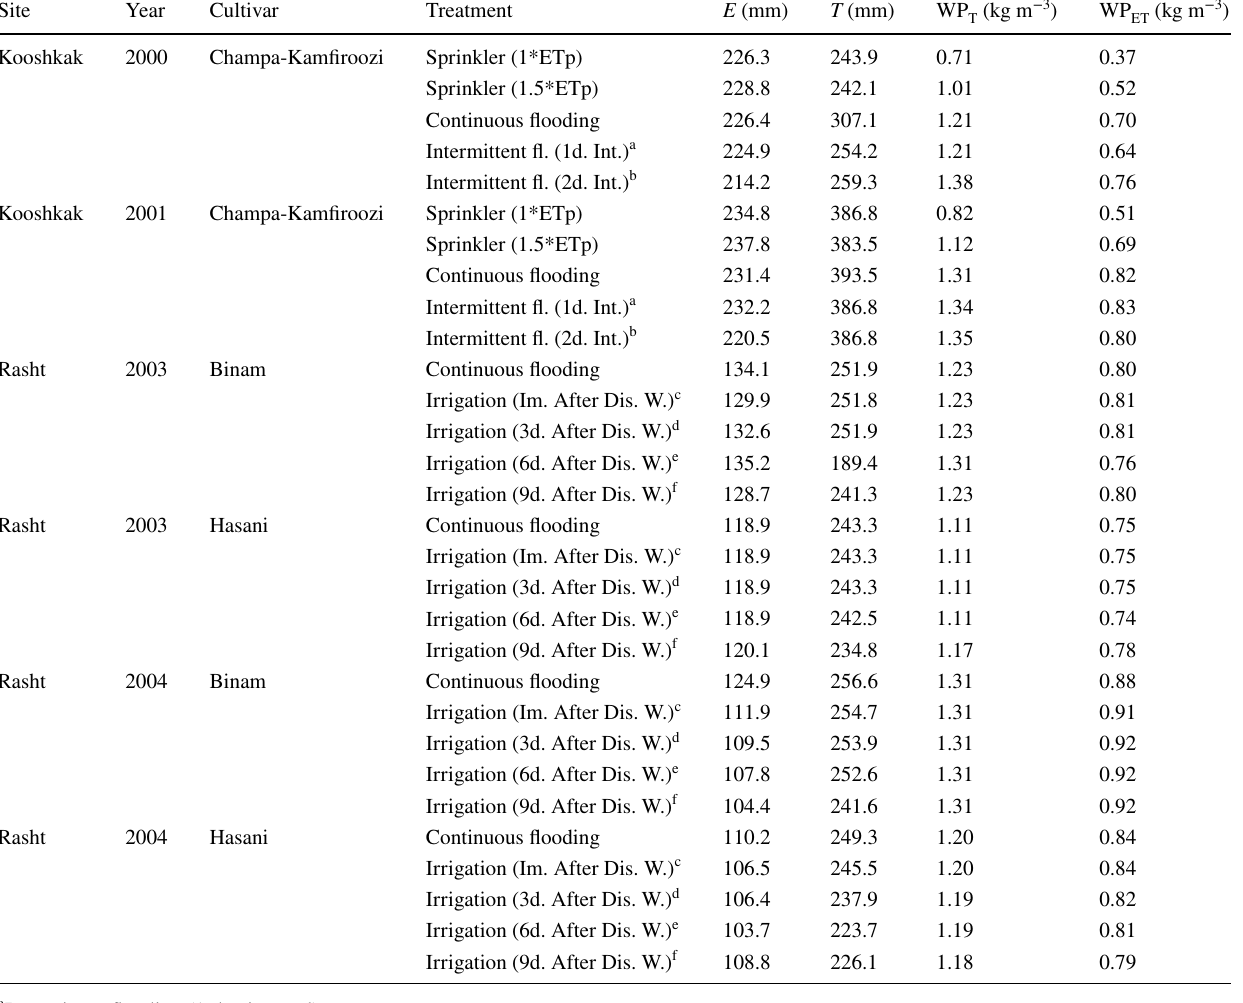
Table 8 Values of evaporation ( E ), transpiration ( T ) and water productivity based on transpiration (WP ferent irrigation treatments for both experimental